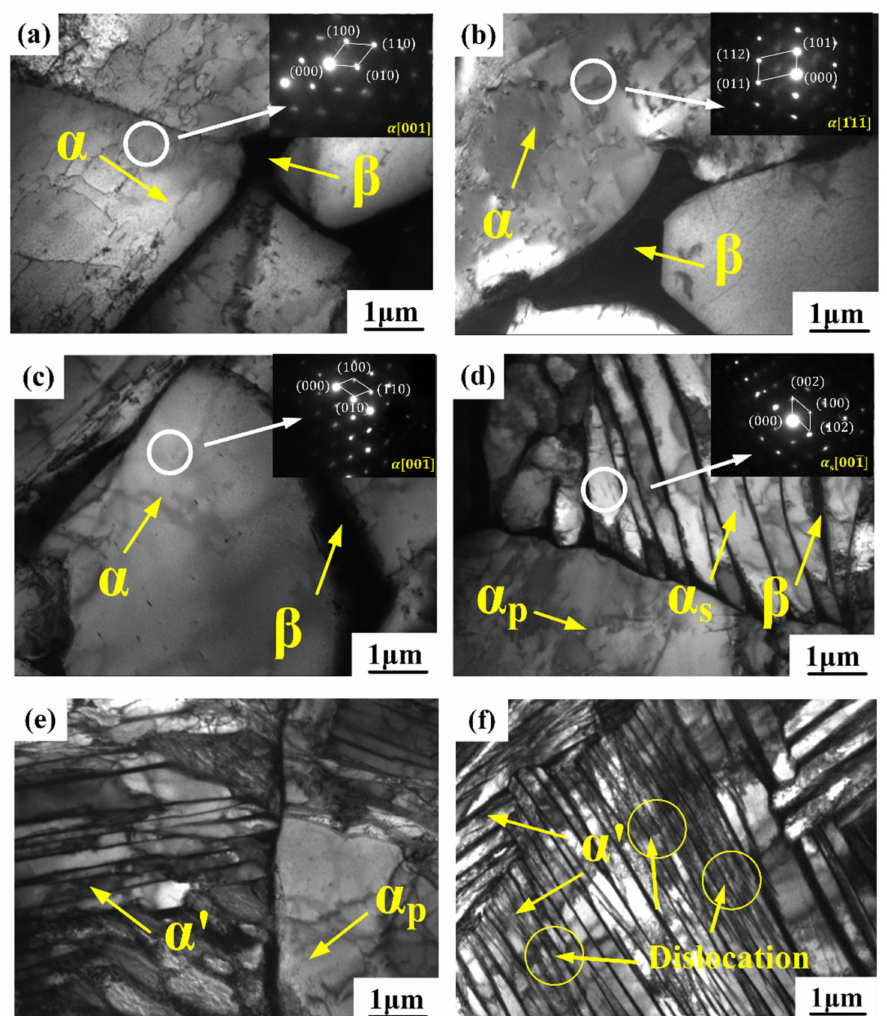
Figure 8. The bright-field TEM images and corresponding SAED patterns of. Zr-4Hf-3Nb (wt%) alloy